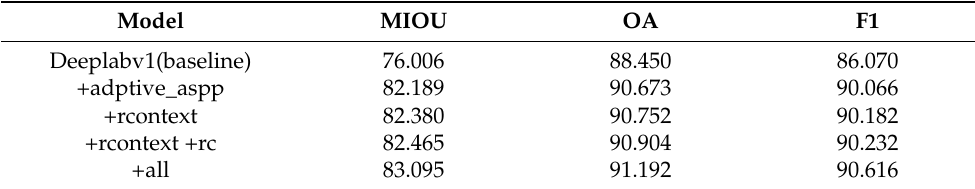
Table 2. Ablation study for various regional structures.